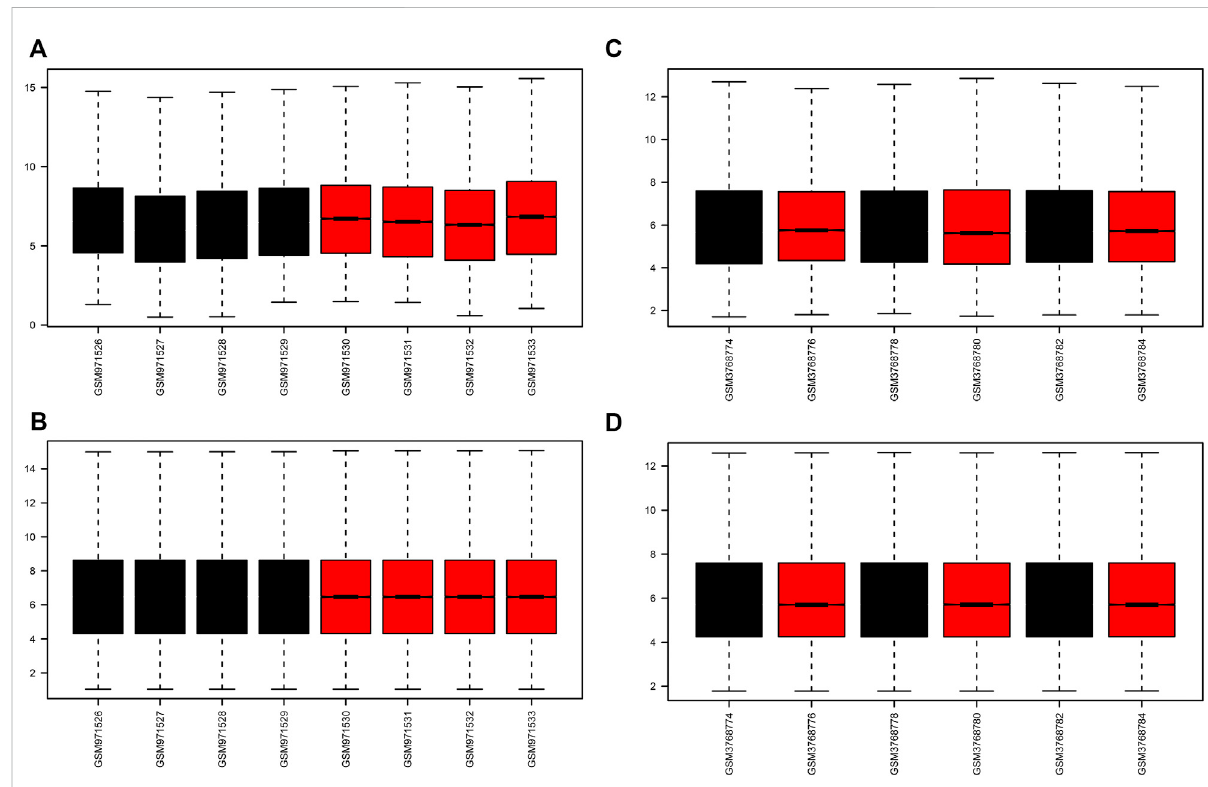
FIGURE 2 Boxplots of GEO dataset samples before and after correction. (A – B) GSE39548 dataset before and after correction; (C – D) GSE131288 dataset before and after